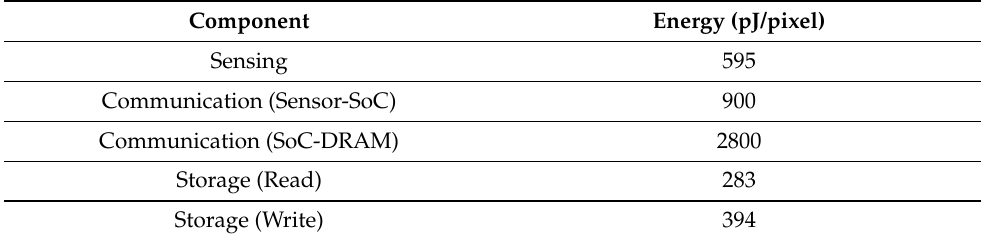
Table 1. Energy-per-pixel of various